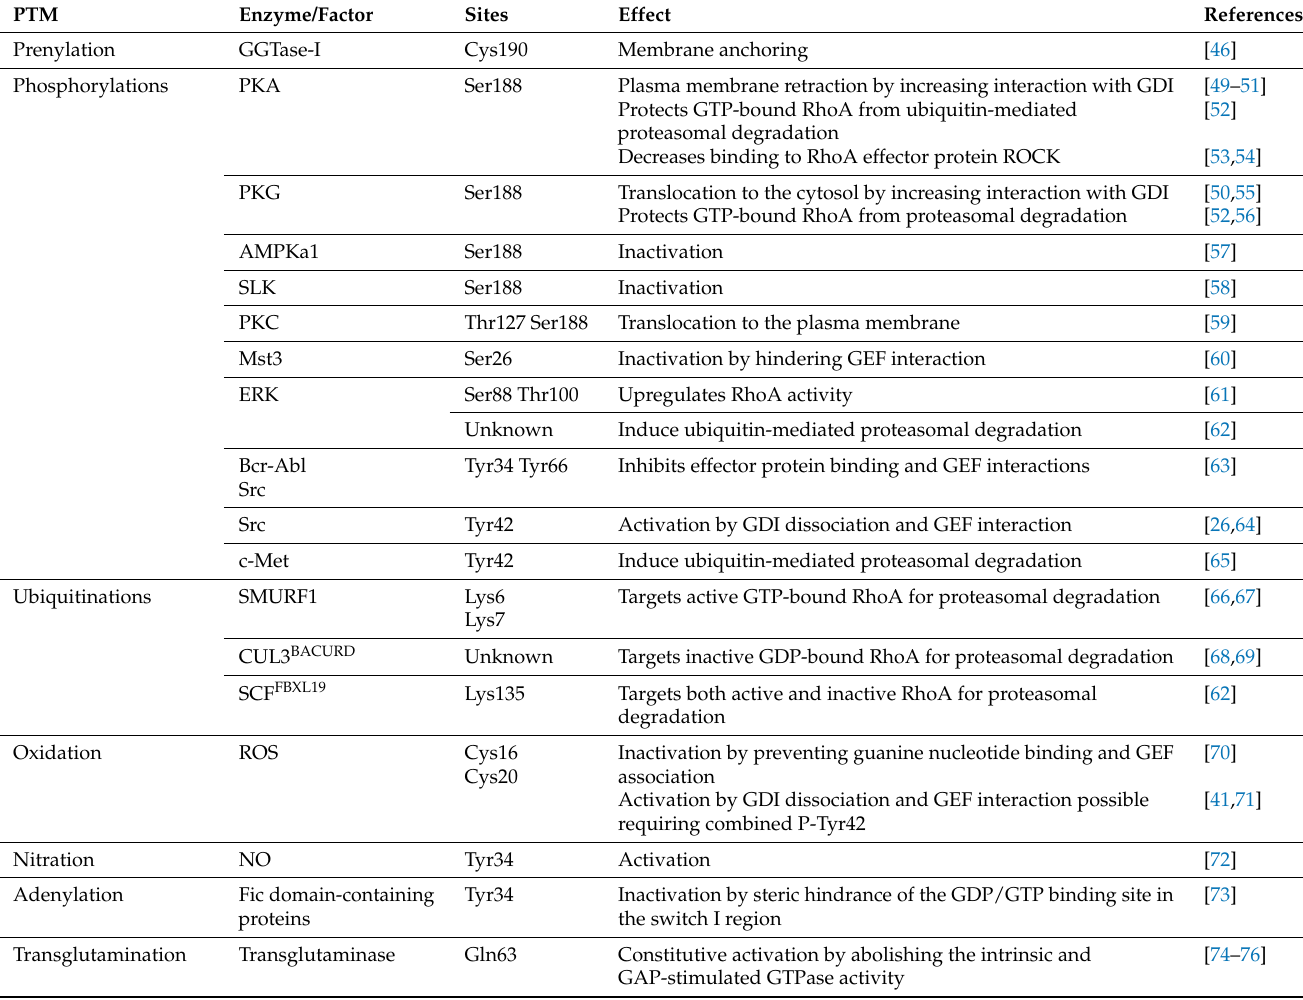
Table 2. Post-translational modifications of